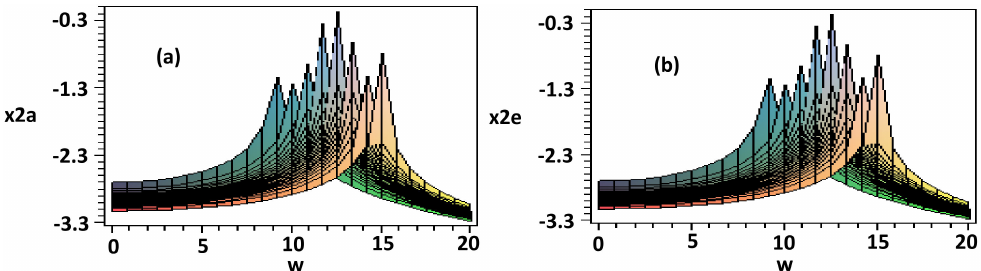
Figure 11. Evolution of x 2 (w) as a function of P 1 : ( a ): Present approach ( b ): Exact solution. Figure 12a,b show the evolution of the first and second circular natural frequency, respectively, as a function of the probability P 1 (k 1 ).